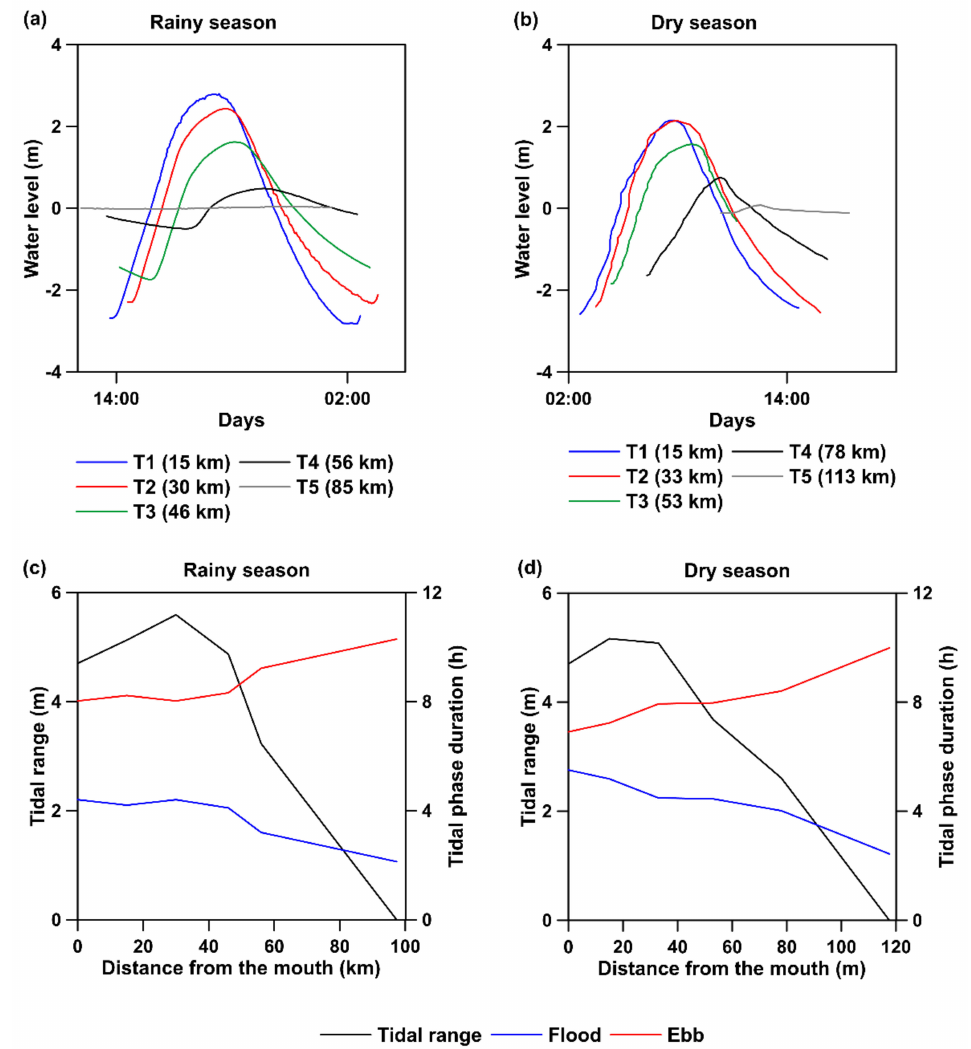
Figure 8. Water level oscillation along the Gurupi estuary. Panels ( a , b ) show the oscillation during rainy and dry seasons, respectively. Panels ( c , d ) show the longitudinal variation of tidal range and tidal phase duration during rainy and dry